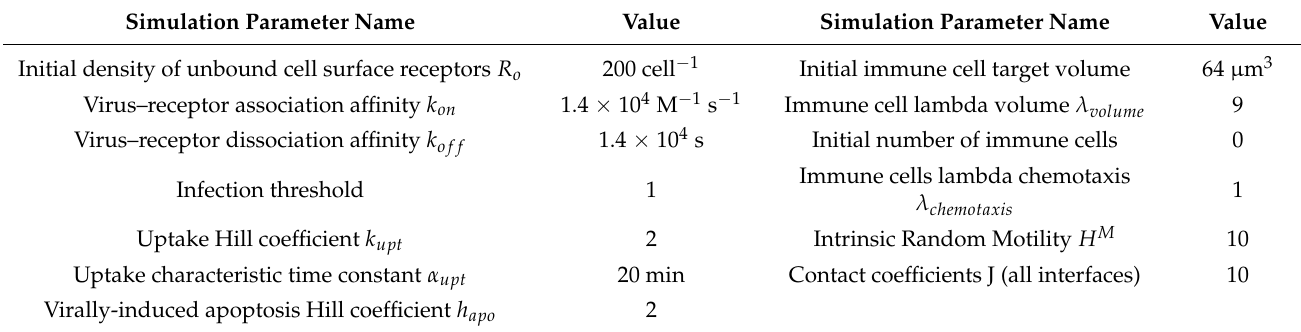
Table A4. Sego et al.’s parameters part